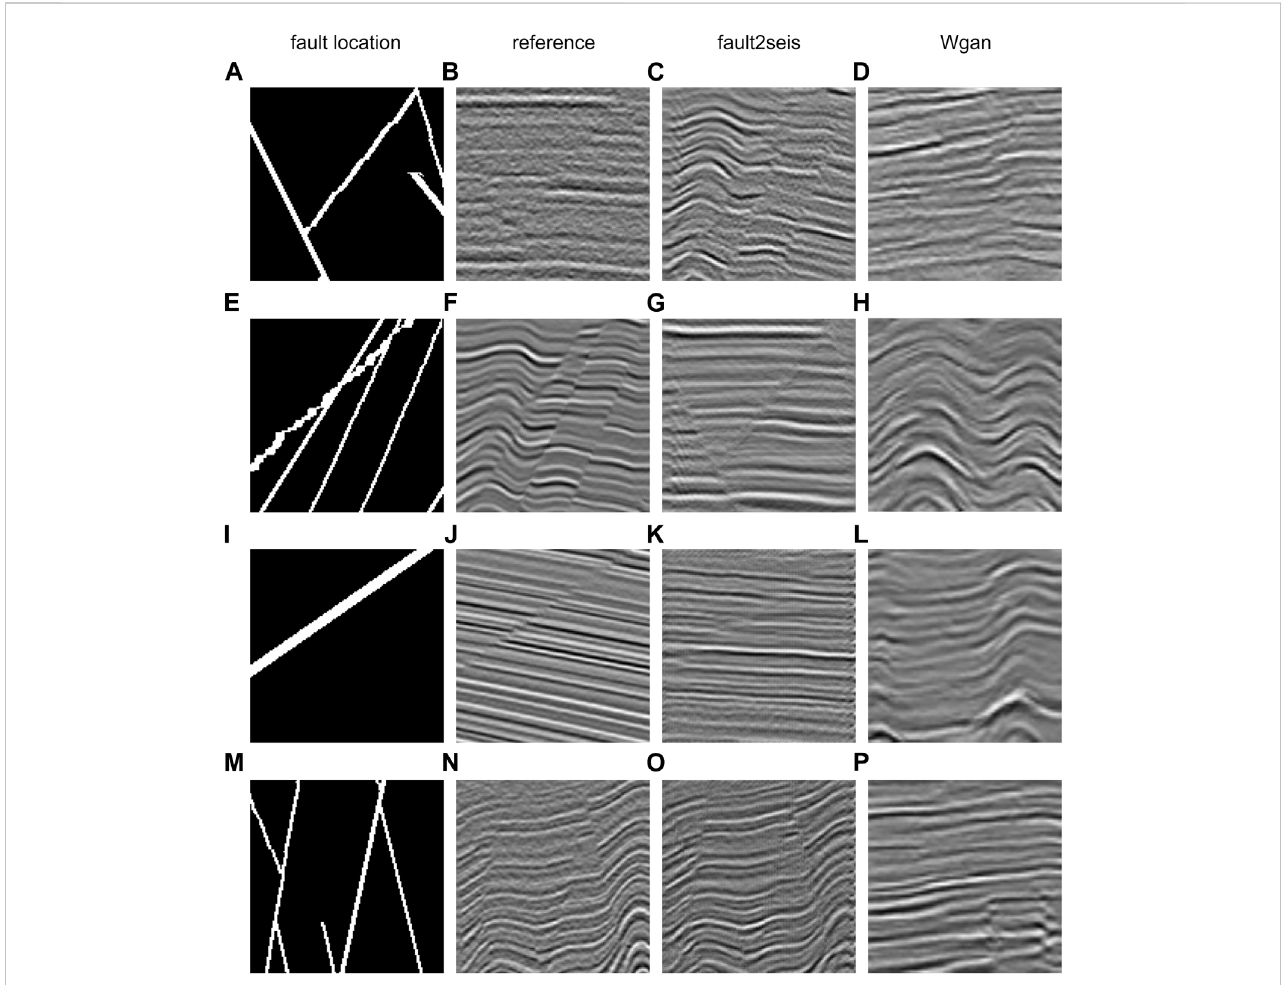
FIGURE 3 Comparison of the results using the test set. Fault2SeisGAN was used to generate amplitude data with labels (A, E, I, M) . Compared with the test dataset (B, F, J, N) , the Fault2SeisGAN ’ s results (C, G, K, O) has a similar structure, and fold features can also be learned by the network. Wgan ’ s results (D, H, L, P) as a comparison. The fault location is highly consistent with the